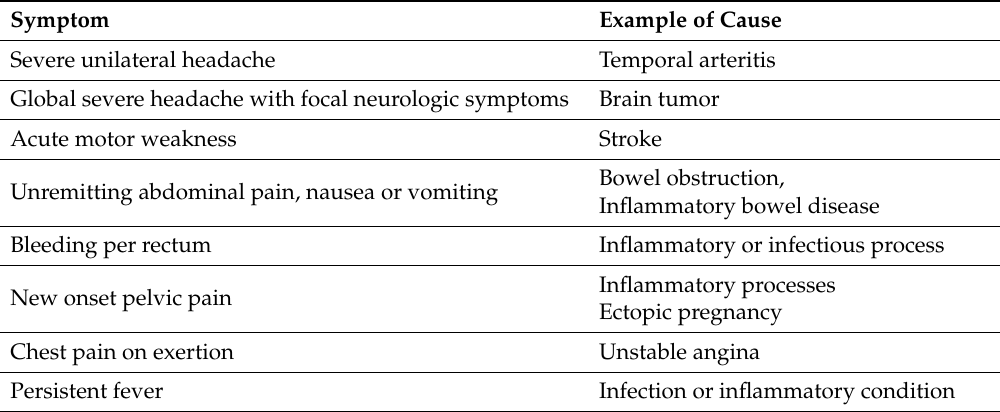
Table A2. Examples of Medical Symptoms not Explainable by Emotional Factors Alone.